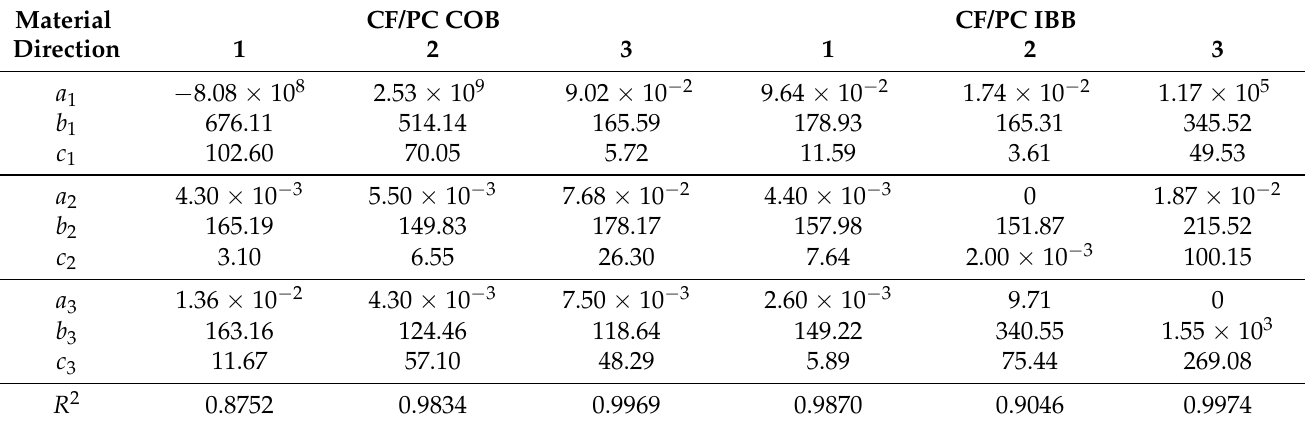
Table A2. Gaussian fitting parameters for CF/PC